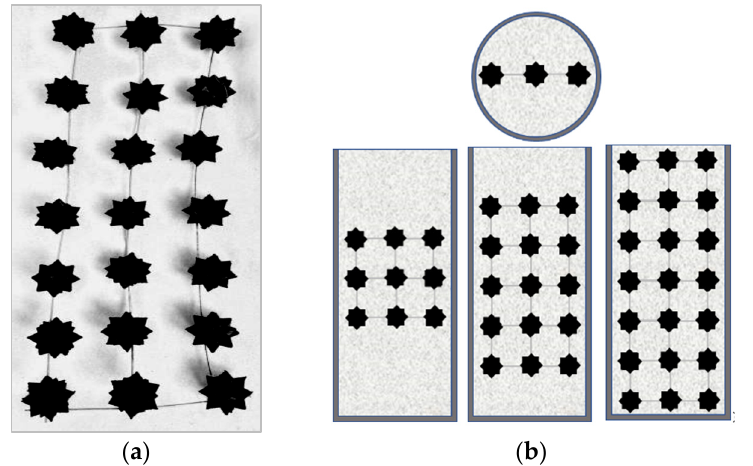
Figure 4. ( a ) Origami aggregate before casting; ( b ) Schematics of the 9, 15, and 21 OBAs inside the cylinder at 20 mm spacings.